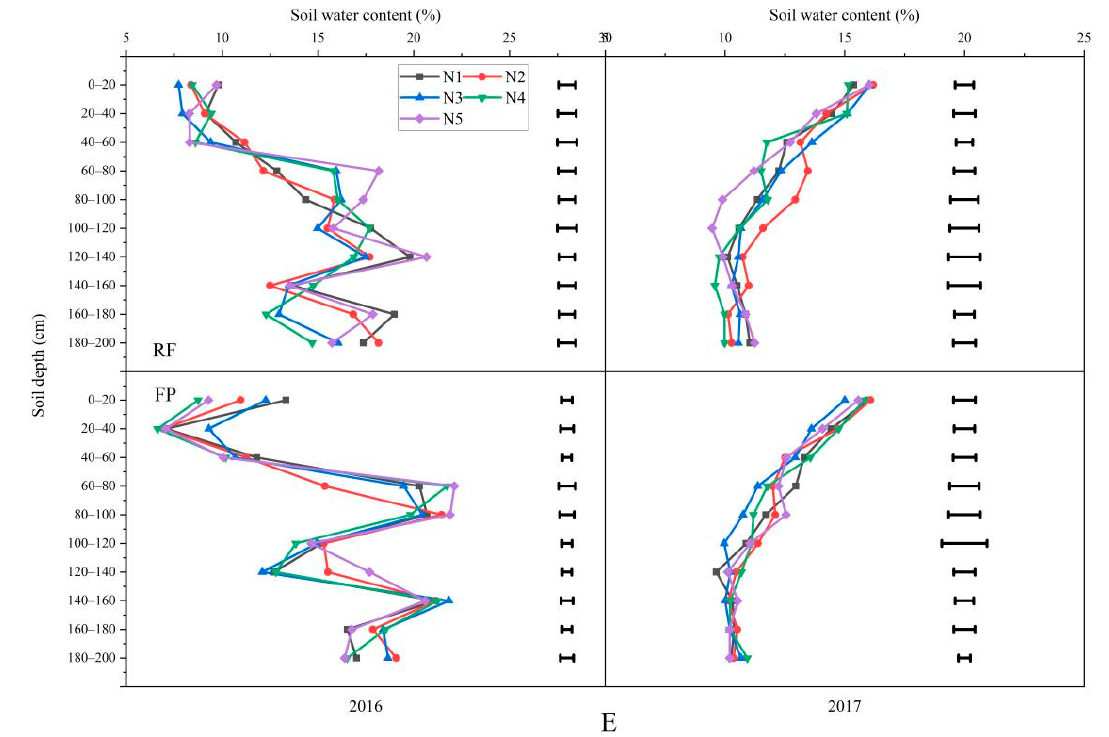
Figure 5. Soil water content at variable depths up to 200 cm during the growth of the plants, recorded for 5 developmental stages in 2 years. Four panels are shown per stage, with (clockwise starting top left) RF in 2016, RF in 2017, FP in 2017, and FP in 2016. ( A ) Seedling stage; ( B ) jointing stage; ( C ) tasseling stage; ( D ) filling stage; ( E ) physiological maturity stage. RF ridge–furrow plastic film mulching; FP flat planting with plastic film mulching. N1, NO 3 − :NH 4+ ratios of 1:0; N2, NO 3 − :NH 4+ ratios of 1:1; N3, NO 3 − :NH 4+ ratios of 1:3; N4, NO 3 − :NH 4+ ratios of 3:1; N5, urea was the sole nitrogen source.